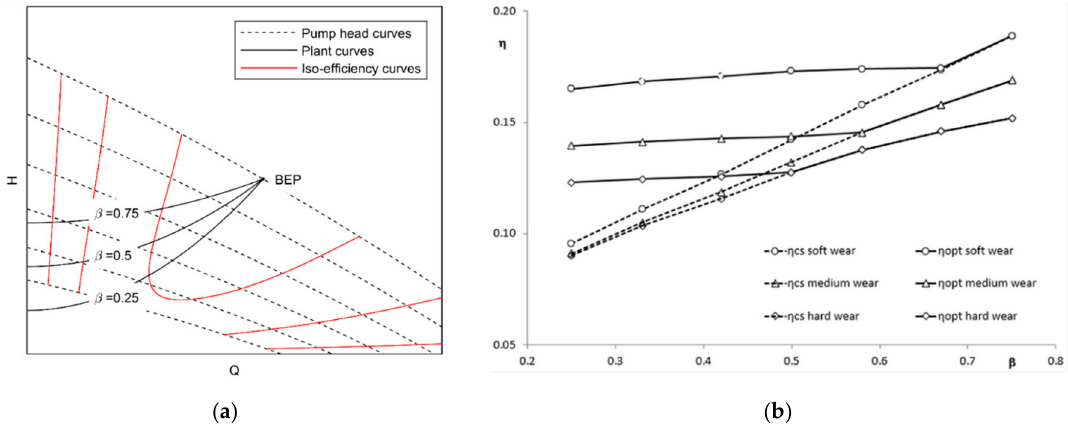
Figure 17. ( a ) Simulated plant head curve; ( b ) global plant efficiency for different stages of wear.